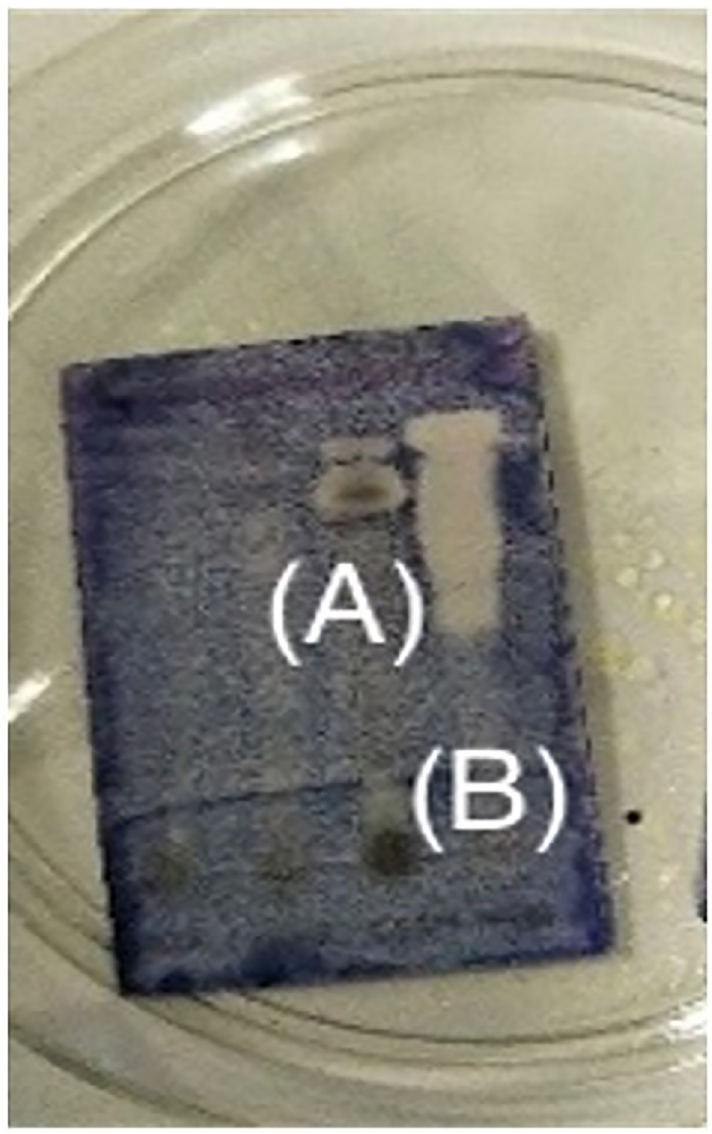
Fig 3. TLC-bioautography of the methanol extract (A) and ethyl acetate extract (B) after spraying with E . faecalis bacterial culture.